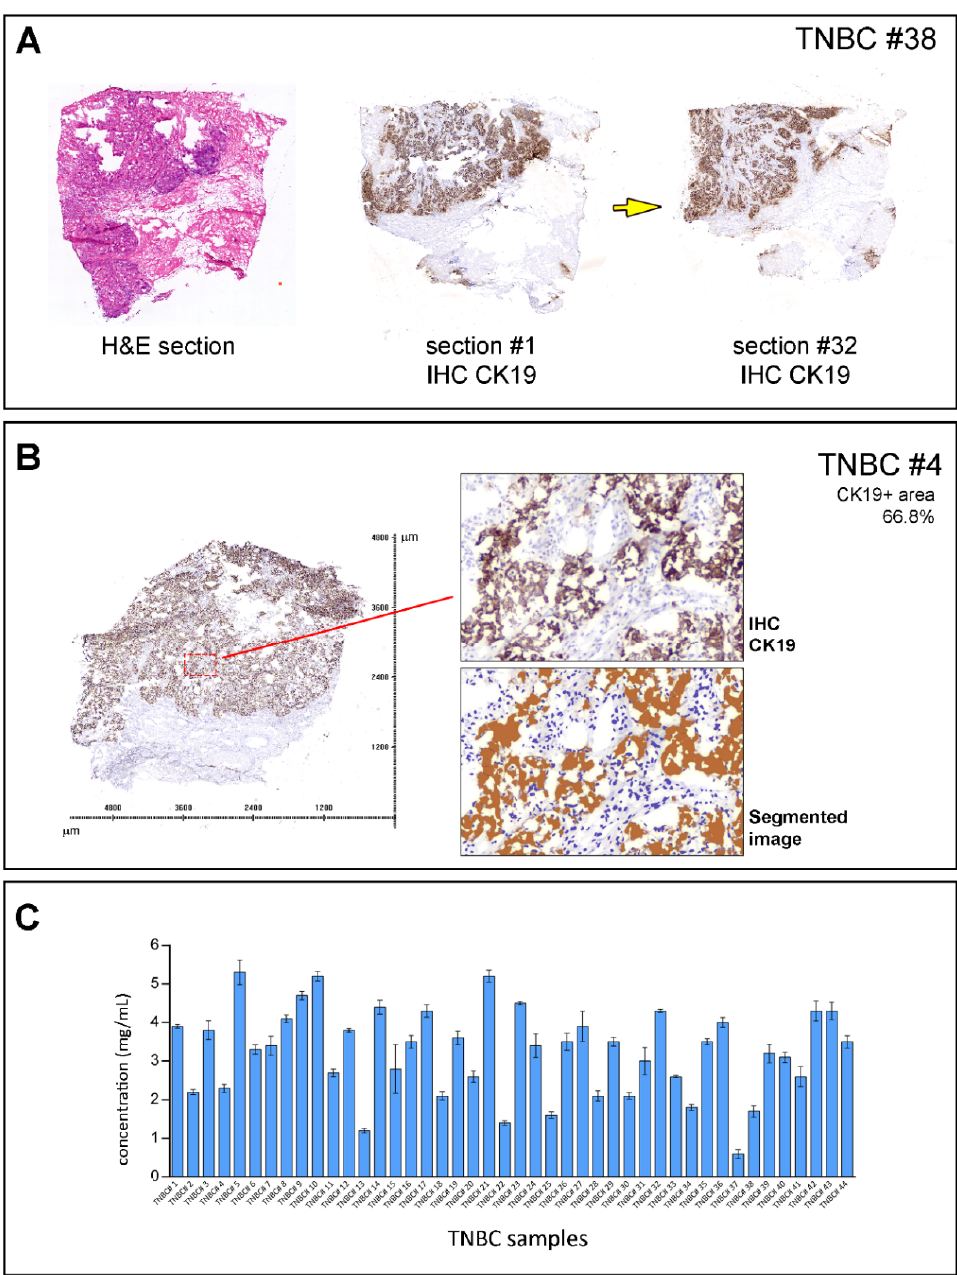
Figure 1. Sample preparation workflow. ( A ) Sample biopsies were serially sectioned and first and last sections stained with hematoxylin and eosin (HE) and cytokeratin 19 (CK19; an epithelial cell marker) for pathology reevaluation. Yellow arrow indicates section order. ( B ) Tandem sections were stained with CK19 to assess the tumor cell area for each sample. Tissue sections stained with CK19 were scanned, and images were segmented and analyzed with image processing software (Visiopharm, Hørsholm, Denmark), which allowed for the quantification of relative tumor cell content. Only samples with tumor cell content >60% were included in this study. ( C ) Lysates were prepared by solubilizing cryosections of snap-frozen tissue biopsies in CLB1 lysis buffer and total protein concentrations